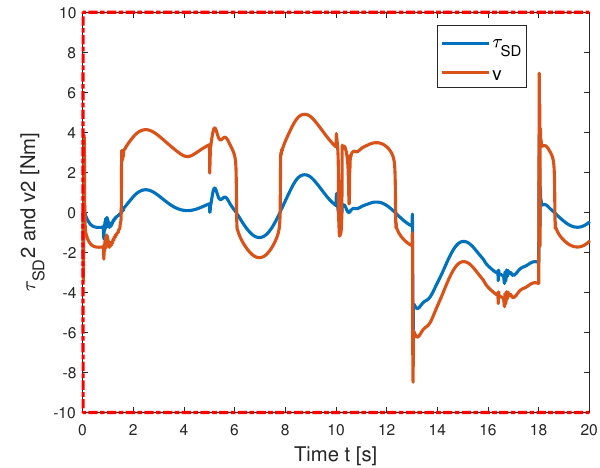
Figure 11. Control inputs τ SD and v for the second joint (NNs-based control).